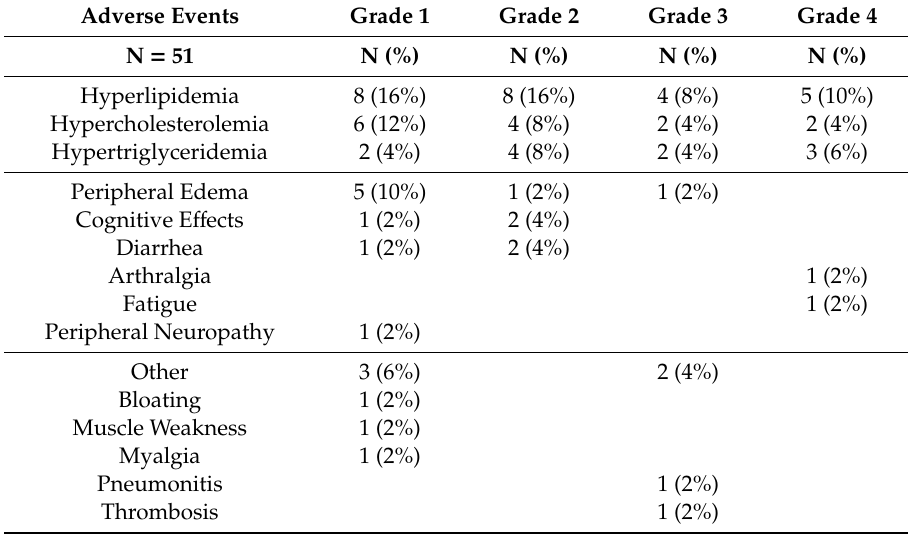
Table 3. Adverse